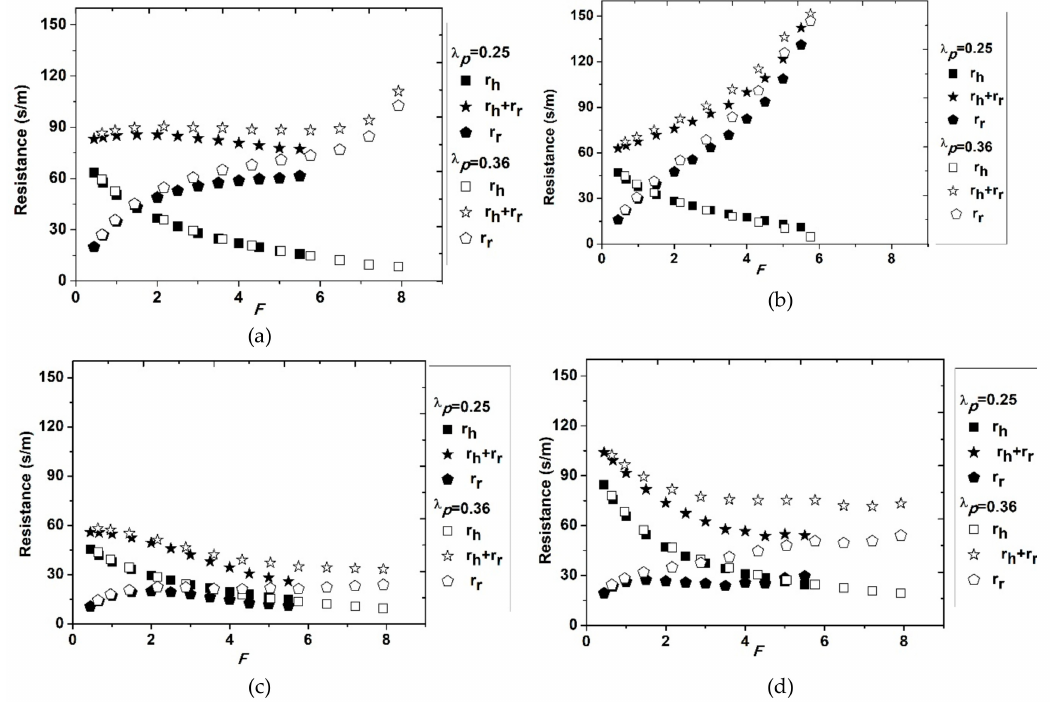
Figure 4. Resistances ( r h , r h + r a , r a , r h + r r , r r in Equations (2)–(4)) versus F under di ff erent conditions: ( a ) 11 April 2010; ( b ) 29 August 2010; ( c ) 28 October 2010; ( d ) 18 December 2010.